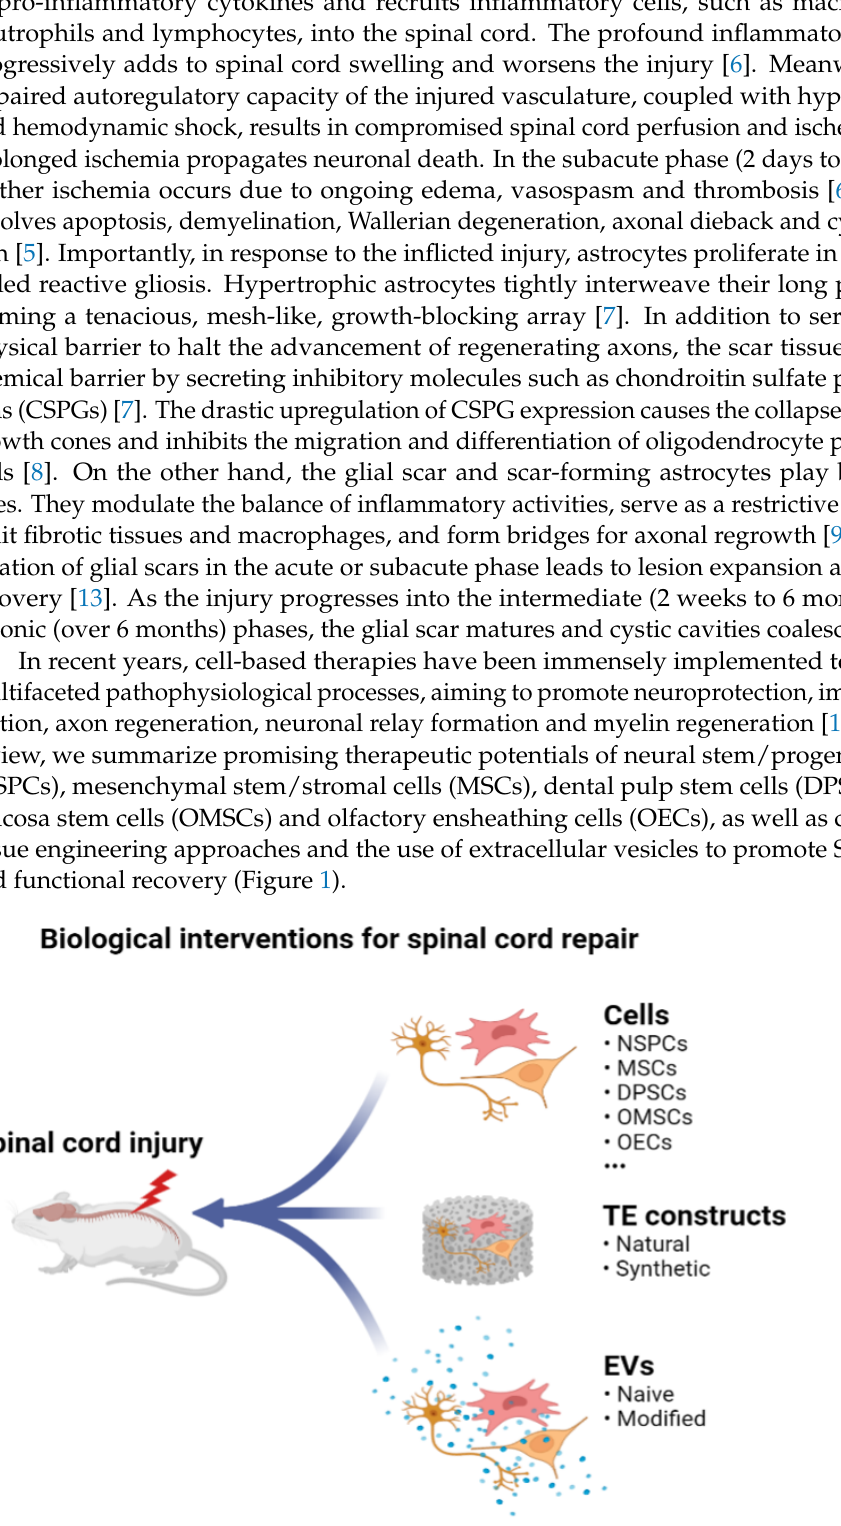
Figure 1. Illustration of biological interventions for spinal cord repair. Cells, tissue-engineered (TE) constructs and extracellular vesicles bear promising therapeutic potentials, and they can be combined for repairing damaged spinal cord tissues. The figure illustration was created using BioRender (https://biorender.com/, accessed on 26 June